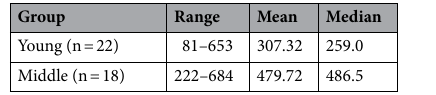
Table 2. Summary statistics for CDI score (word